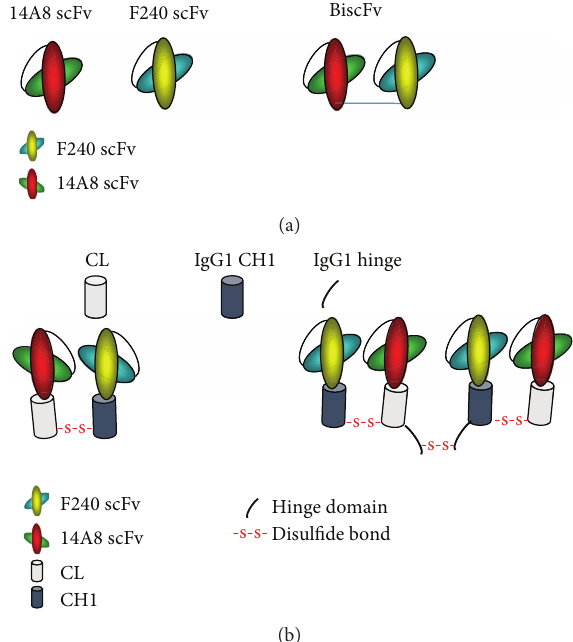
Figure 1: Schematic diagram of F240 × 14A8 Bi-Fab construction. The structure of the bispecific single chain antibody (biscFv) is depicted in (a) with the VH as either the green oval (14A8) or blue oval (F240) and the VL as the red oval (14A8) or yellow oval (F240). (b) represents the organization of the Bi-Fab.